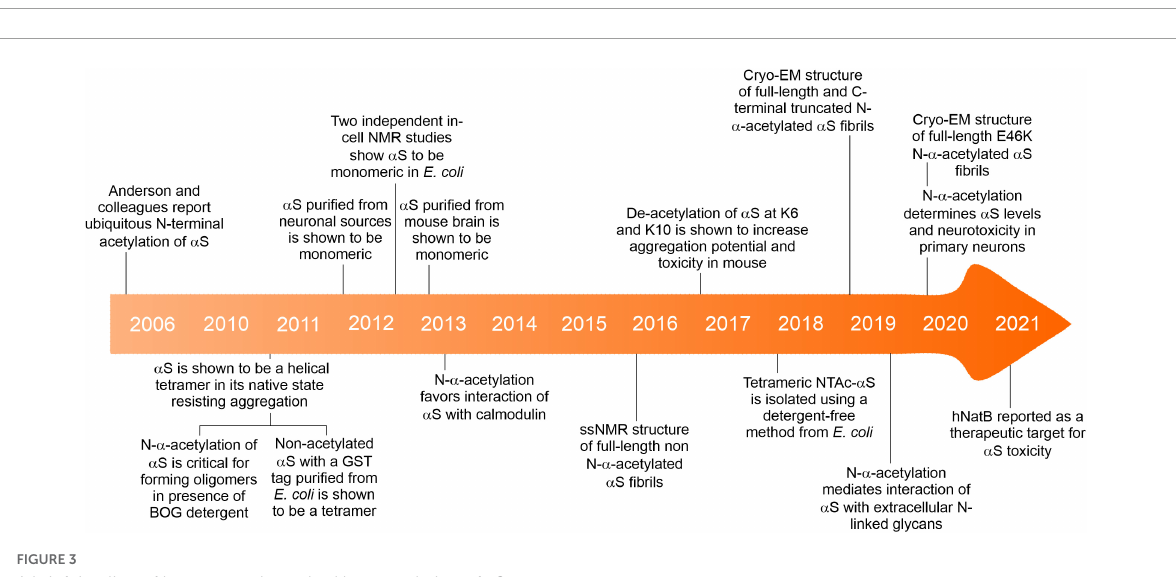
FIGURE3 A brief timeline of key events about the N - α -acetylation of α